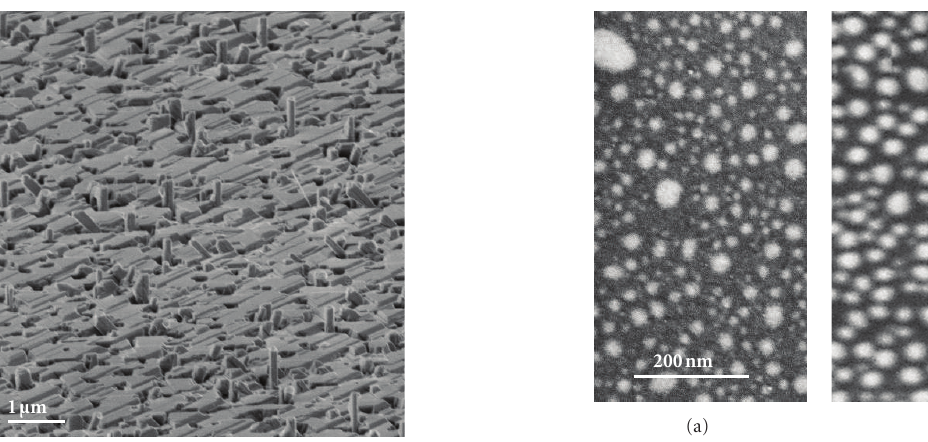
Figure 5: (a) Plan-view SEM image of a sample deposited with 2nm-thick Au layer and sequent annealed at 700 ◦ C for two hours. (b) Plan-view SEM image of a sample in which the same gold thickness has been evaporated directly at the same NWs growth temperature of 480 ◦